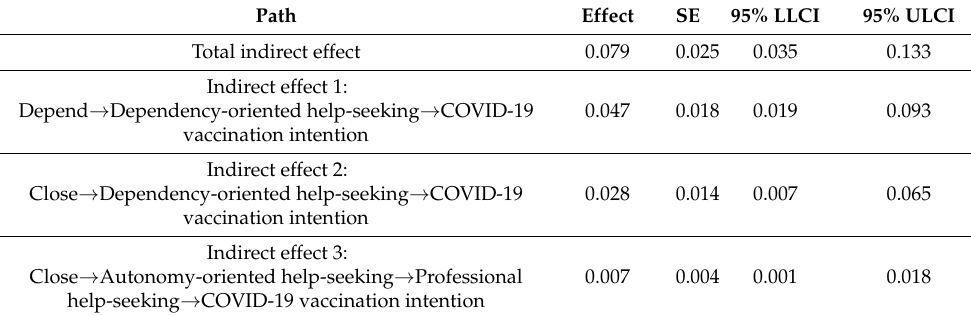
Table 2. Standardized indirect path effects from adult attachment to COVID-19 vaccination